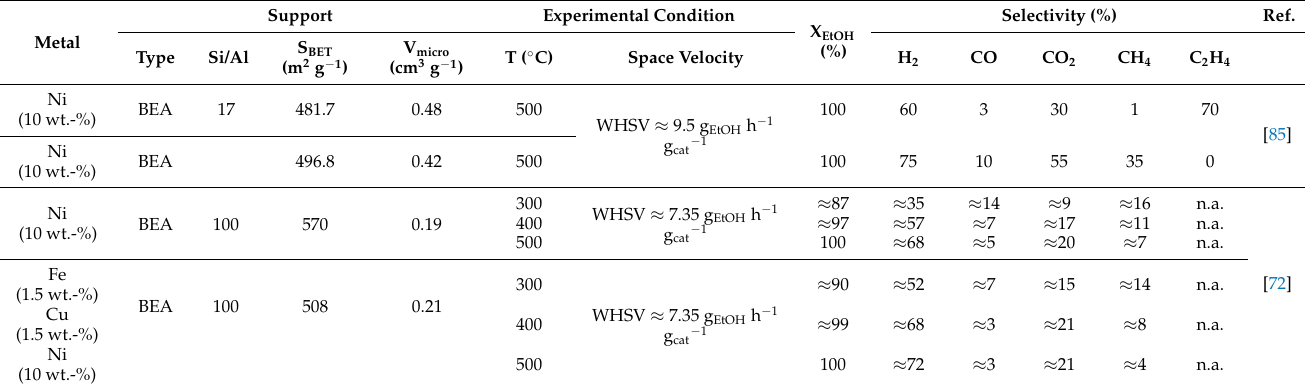
Table 3. BEA support for various types of metal catalysts for the ESR